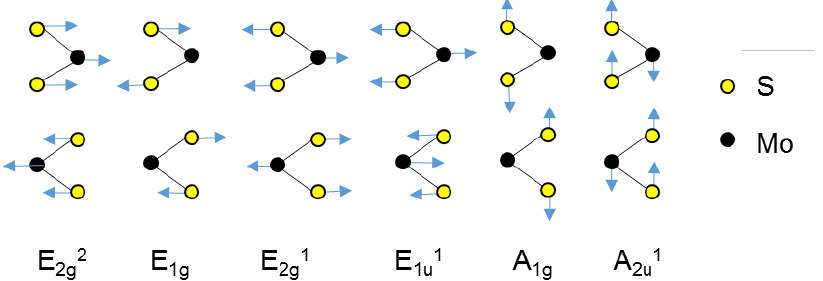
Figure 6. Atomic displacement vector of the four first-order Raman-active E 2g2 , E 1g , E 2g1 , A 1g modes and two IR-active E 1u1 and A 2u1 modes, as viewed along the [100] direction [81–83].